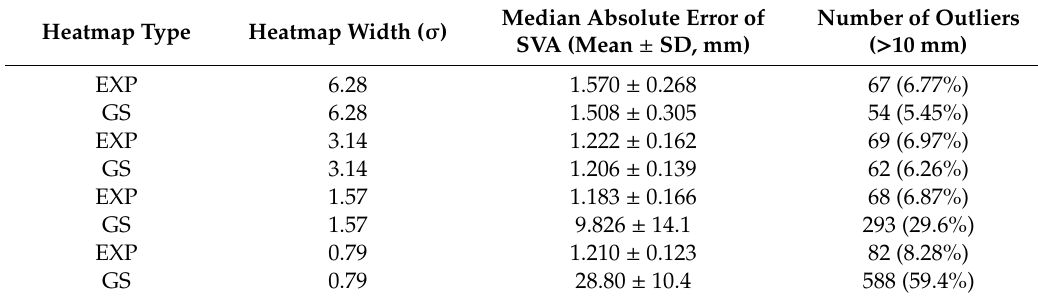
Table 2. The median value and number of outliers of the absolute errors of SVA are reported for models constructed using di ff erent hyperparameter settings. Mean ± standard deviation (SD) of the median value of the absolute errors of SVA were obtained following the procedure of 10-fold